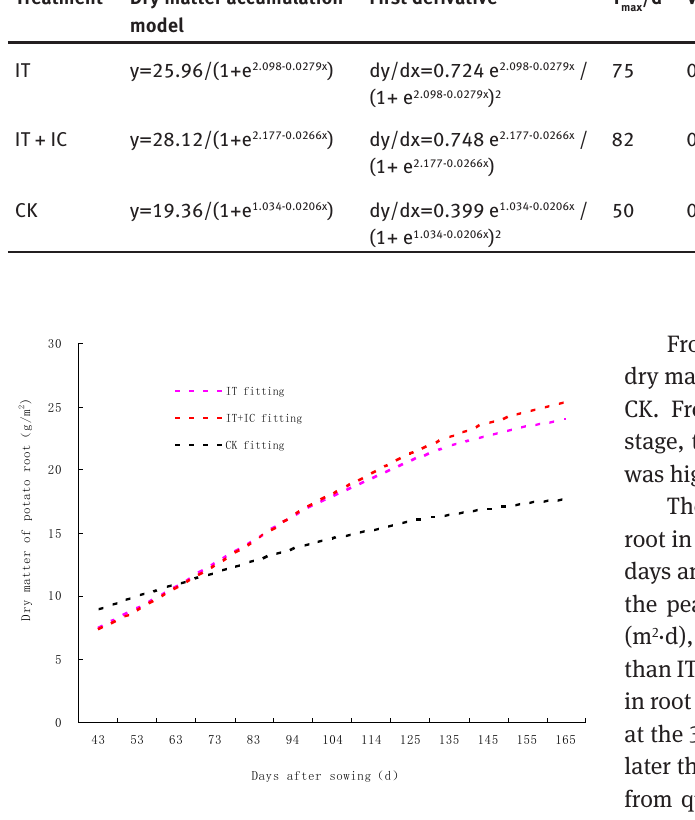
Figure 5: Dynamic simulation curve of dry matter accumulation for potato root in different treatments.